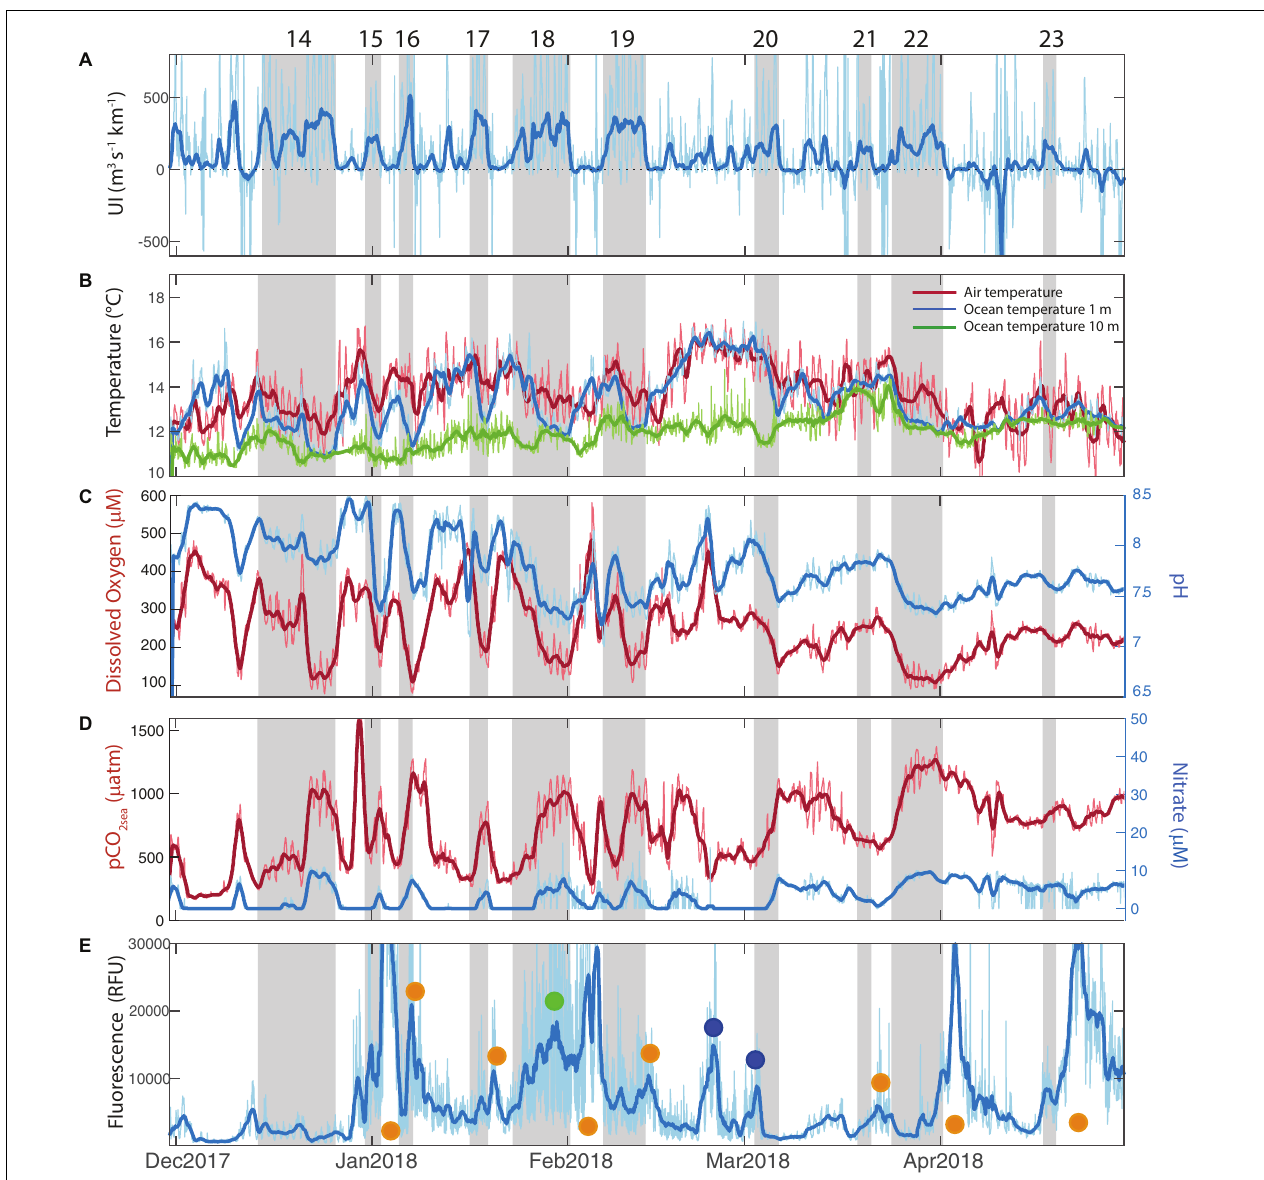
FIGURE 3 | Hourly (thin line) and filtered (thick line) time series between December 2017 and April 2018. Vertical gray bars indicate the periods of the upwelling events. (A) Upwelling Index (m 3 s − 1 km − 1 ), (B) Air temperature ( ◦ C, red line), ocean temperature at 1 m depth (blue line) and ocean temperature at 10 m depth (green line), (C) Dissolved Oxygen ( µ M, red line) and pH (blue line), (D) p CO 2 sea ( µ atm, red line) and Nitrate ( µ M, blue line), and (E) Fluorescence (RFU). Green dots indicates when fluorescence increases during upwelling events, orange dots indicates when fluorescence increases after upwelling events and blue dots indicates when fluorescence increases decupled from alongshore